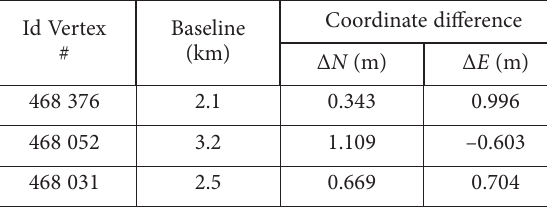
Table 3. NRTK accuracy on three Check Points Id Vertex